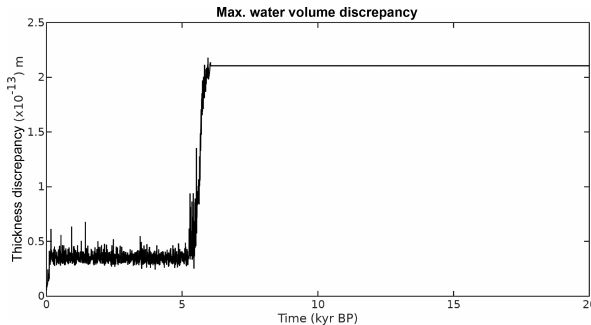
Figure 2. Maximum mass balance discrepancy over